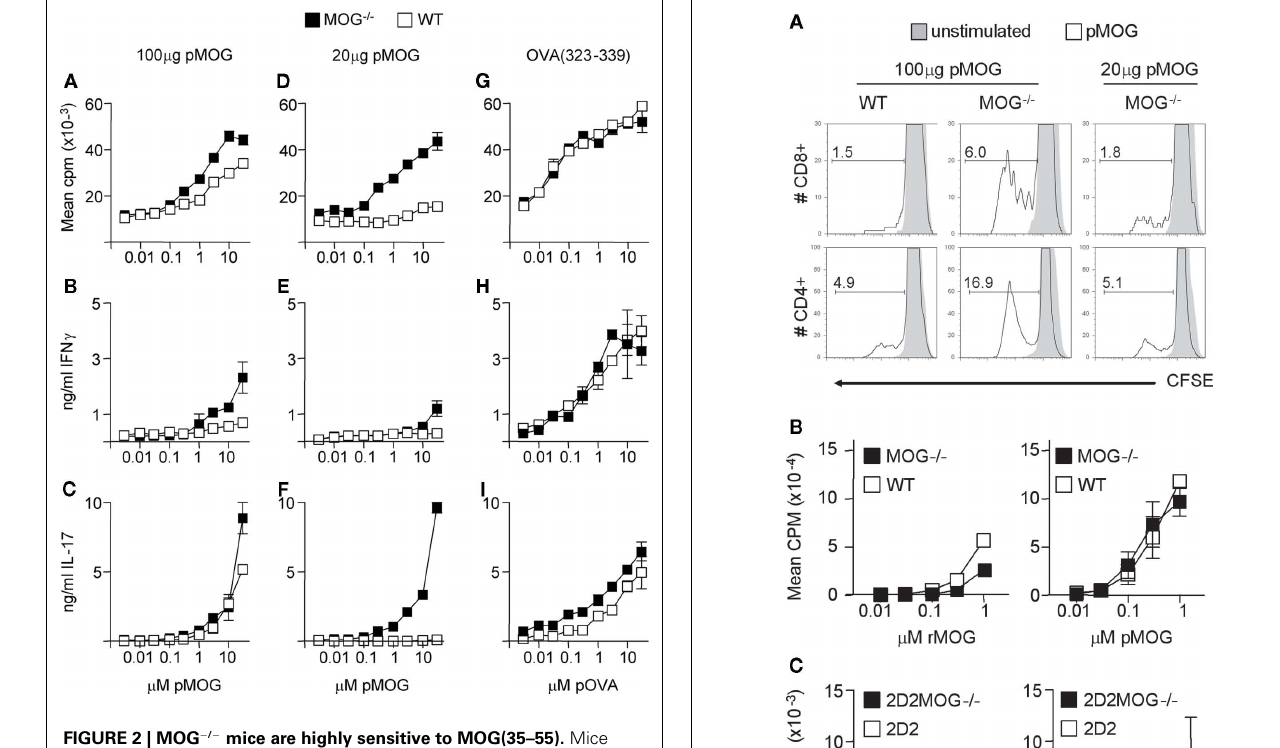
FIGURE 2 | MOG − / − mice are highly sensitive to MOG(35–55). Mice were immunized with either 100 μ g pMOG (A–C) , 20 μ g pMOG (D–F) or 20 μ g OVA(323–339) (G–I) in CFA.Ten days later, splenic recall responses to pMOG or OVA(323–339) were tested as measured by proliferation (A,D,G) , IFN-y production (B,E,H) or IL-17 production (C,F,I) . Each experiment shown in one of two experiments giving consistent results; three mice per group were used.